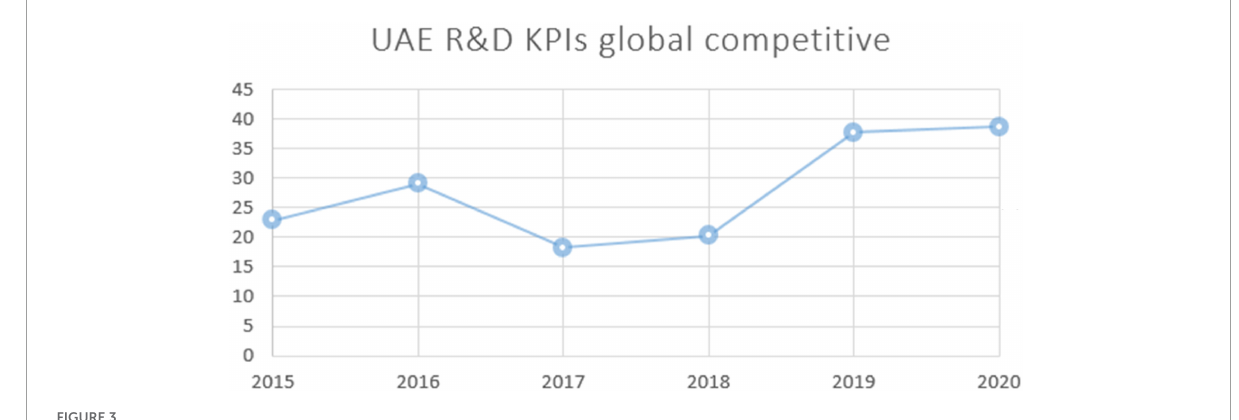
FIGURE3 Innovation technology in UAE (2015–2020) (Index,